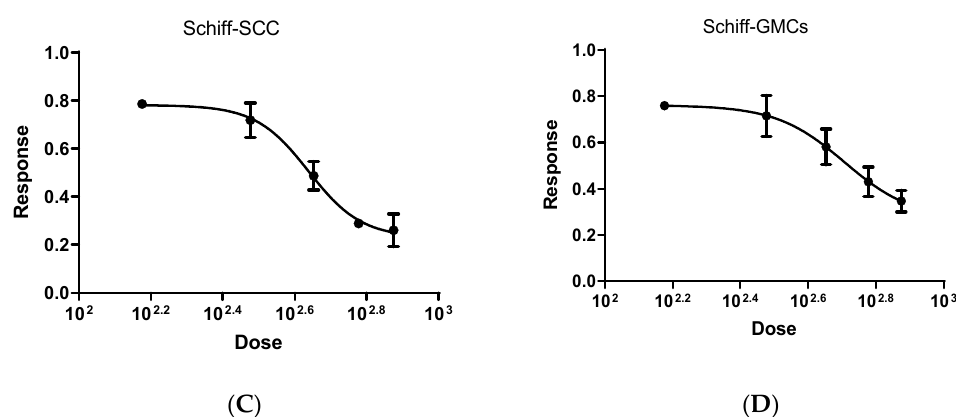
Figure 2. Evaluation of IC50 for different concentrations of Cis on SSC ( A ) and on GMCS ( B ). Evaluation of IC50 for different concentrations of Schiff-base on SSC ( C ) and on GMCS ( D ).